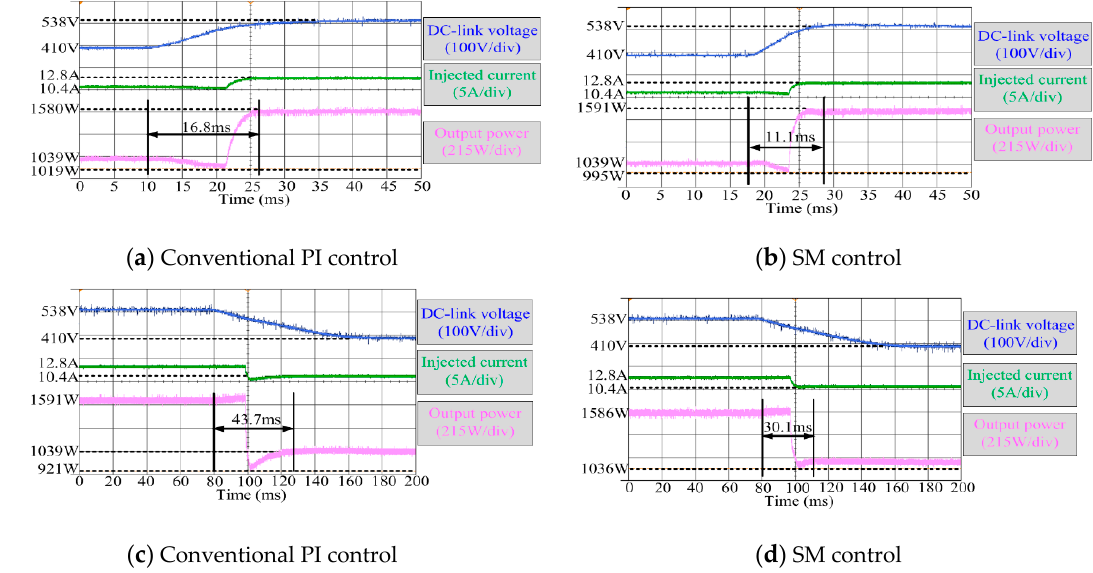
Figure 4. The experimental waveforms of the DC grid voltage, the injected current, and the output power of the entire WEC system for wind speeds altering from 6.6 to 7.9 m/s and vice versa.